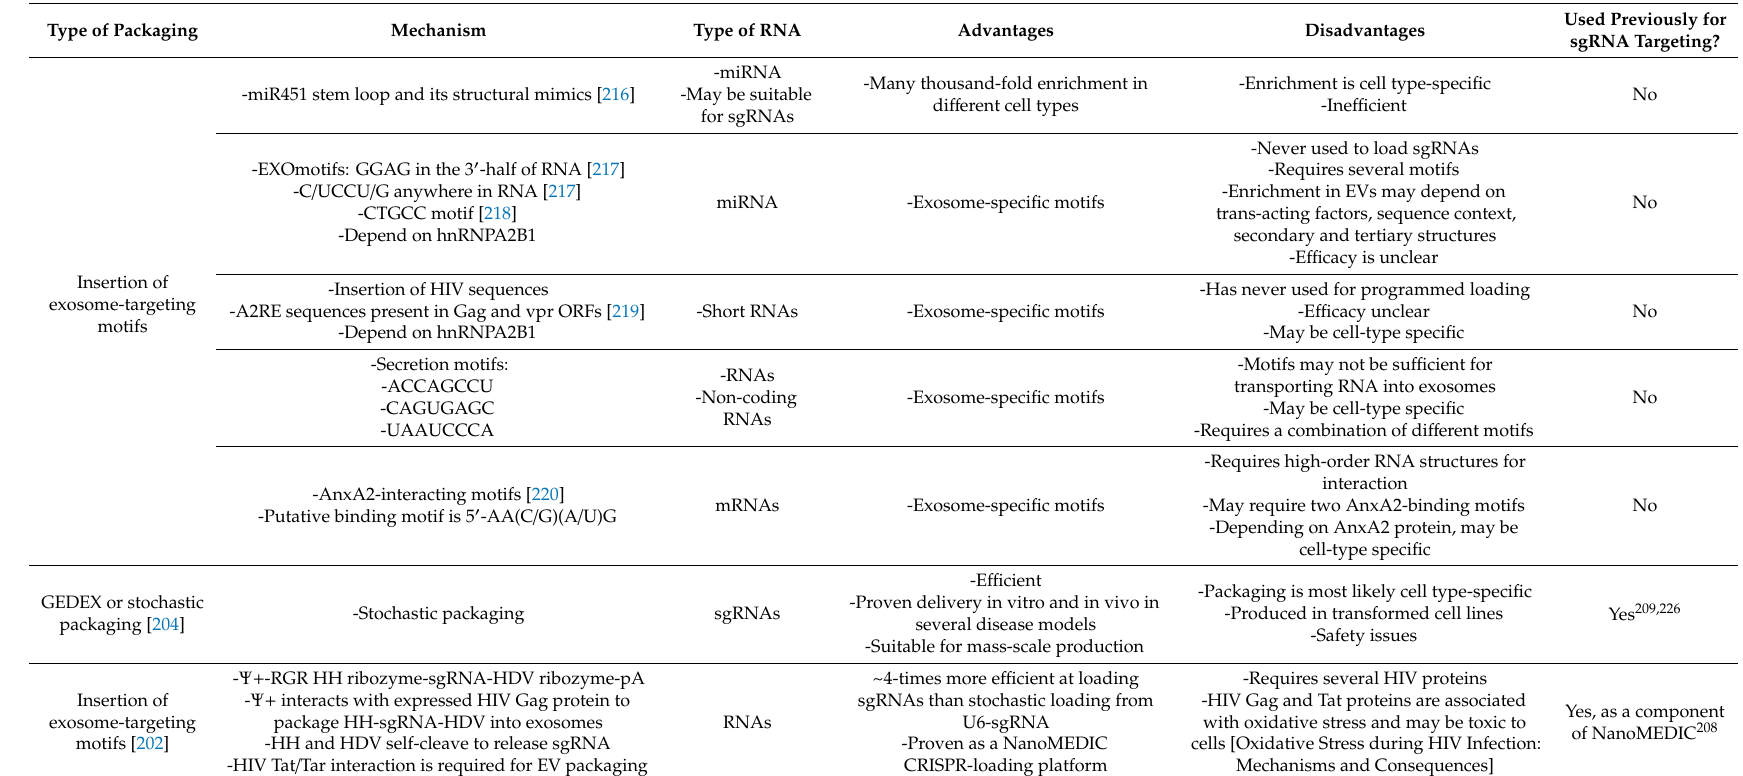
Table 3. Mechanisms for packaging RNAs into